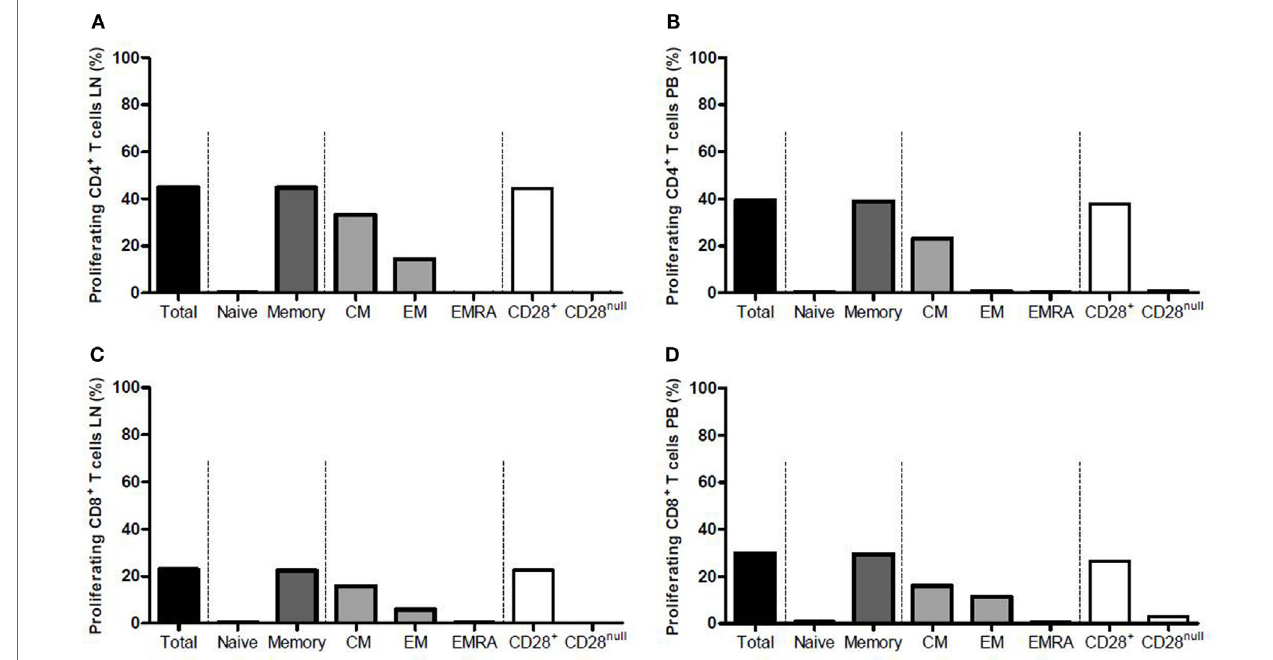
FigUre 4 | Proliferation of CD4 + and CD8 + T cells from the lymph node and peripheral blood after allogeneic stimulation. Frequencies of proliferating CD4 + T cells within (a) the lymph node and (B) the peripheral blood are shown after allogeneic stimulation. Frequencies of proliferating CD8 + T cells within (c) the lymph node and (D) the peripheral blood are shown after allogeneic stimulation. Each graph is divided into four parts marked with the dotted lines. From left to right: the total proliferating T-cell population is shown, which then is subdivided into naïve and memory T cells in the second portion, the third portion shows the subdivision of the memory T-cell population into CM, EM, and EMRA T cells, and the fourth portion shows the subdivision of the total T-cell population into CD28 + and CD28 null T cells. Frequencies are presented with bars and medians. CM, central memory; EM, effector memory; EMRA, effector memory CD45RA +